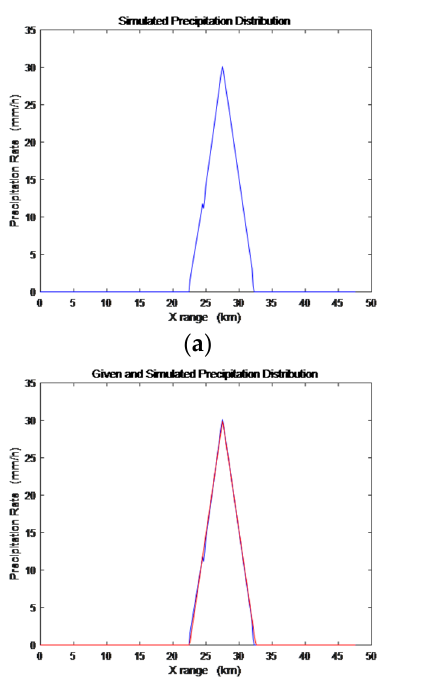
Figure 5. Rectangular bimodal distribution diagrams for 𝑅(𝑥) = 10 mm/h . ( a ) Given precipitation distribution; ( b ) Simulated precipitation distribution; ( c ) Given precipitation distribution and simulated precipitation distribution; ( d ) Relative error between given and simulated results.